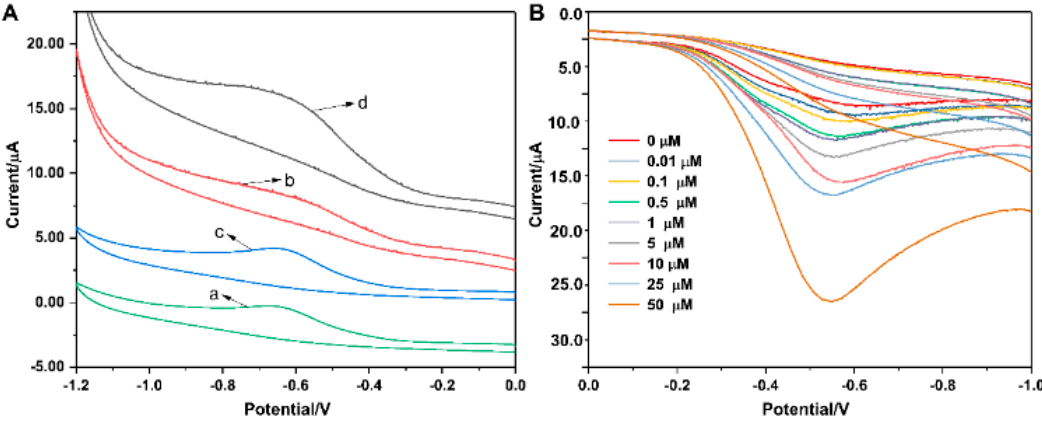
Figure 3. ( A ) Cyclic voltammogram of bare glass carbon electrode (GCE) (a,c) and Ag-mSiO 2